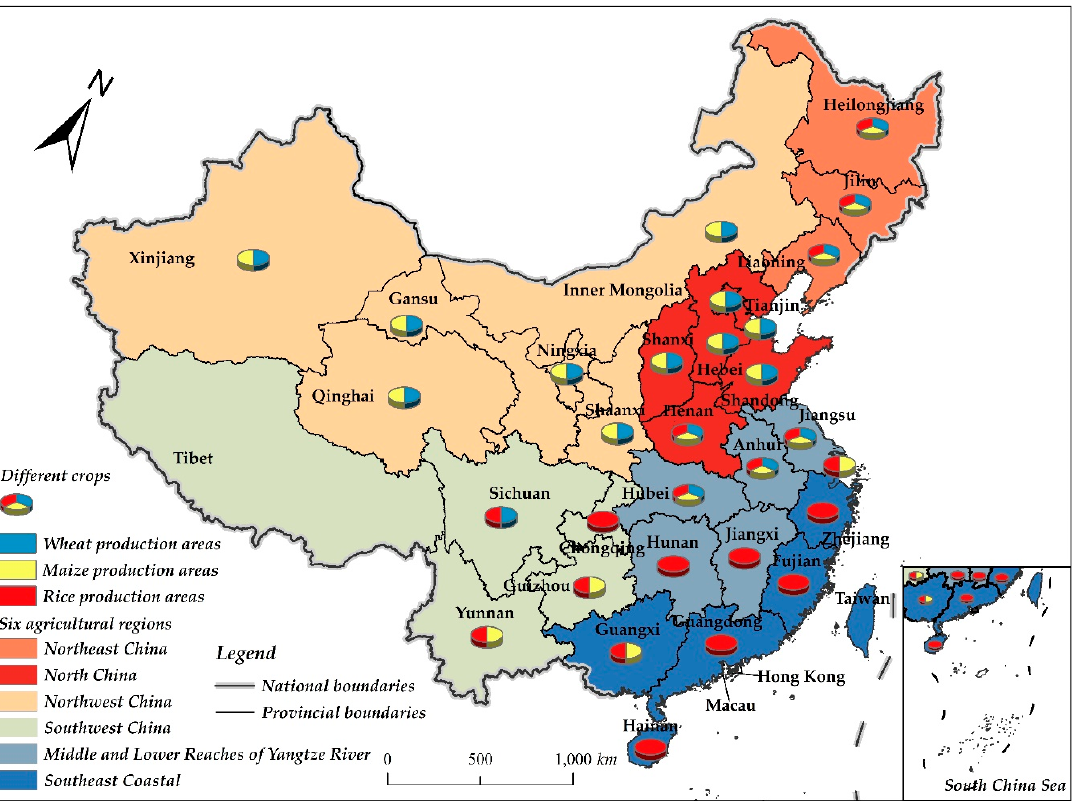
Figure 1. Three major crops production areas and six agricultural zones in China. (Note: Due to the limited availability of data, Hong Kong, Macau and Taiwan were not included in the empirical analysis).